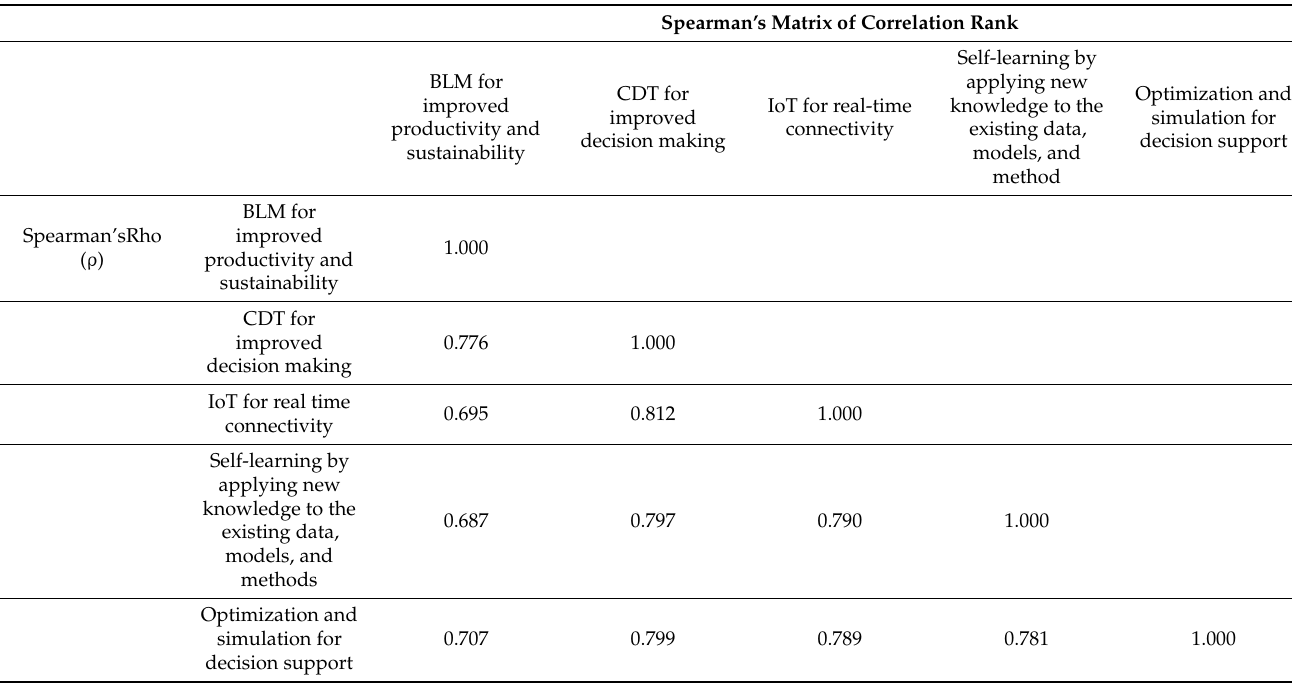
Table 5. Correlational analysis of Cognitive Digital Twins’ perception of decision support